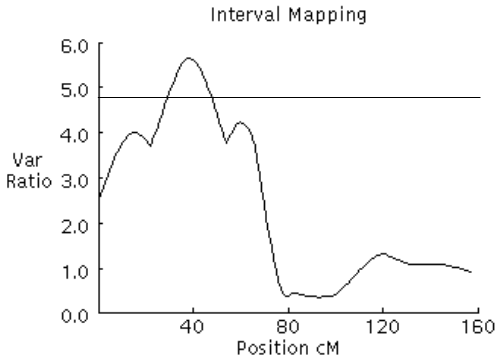
Figure 2. F-ratio curves for intramuscular fat on chromosome 6. The x-axis indicates the relative position on the linkage map. The y-axis represents the F-ratio. The two lines represent the 5% chromosome-wide (  ) and 1% chromosome-wide (  ) significance levels from the permutation test.